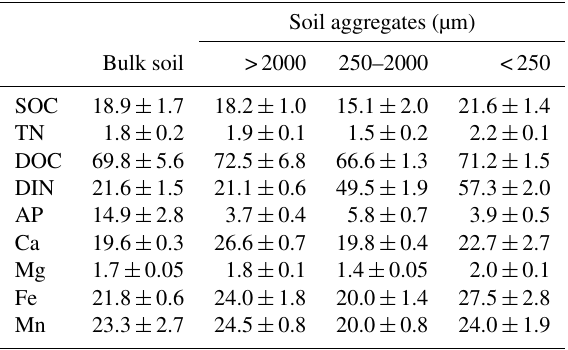
Table 2. Two-way ANOVAs ( F values) of the effect of soil aggre- gate size (S), nitrogen addition (N), and their interactions on the ra- tios of DOC:DIN, DOC:AP, DIN:AP, exchangeable Ca:Mg, and available Fe:Mn.